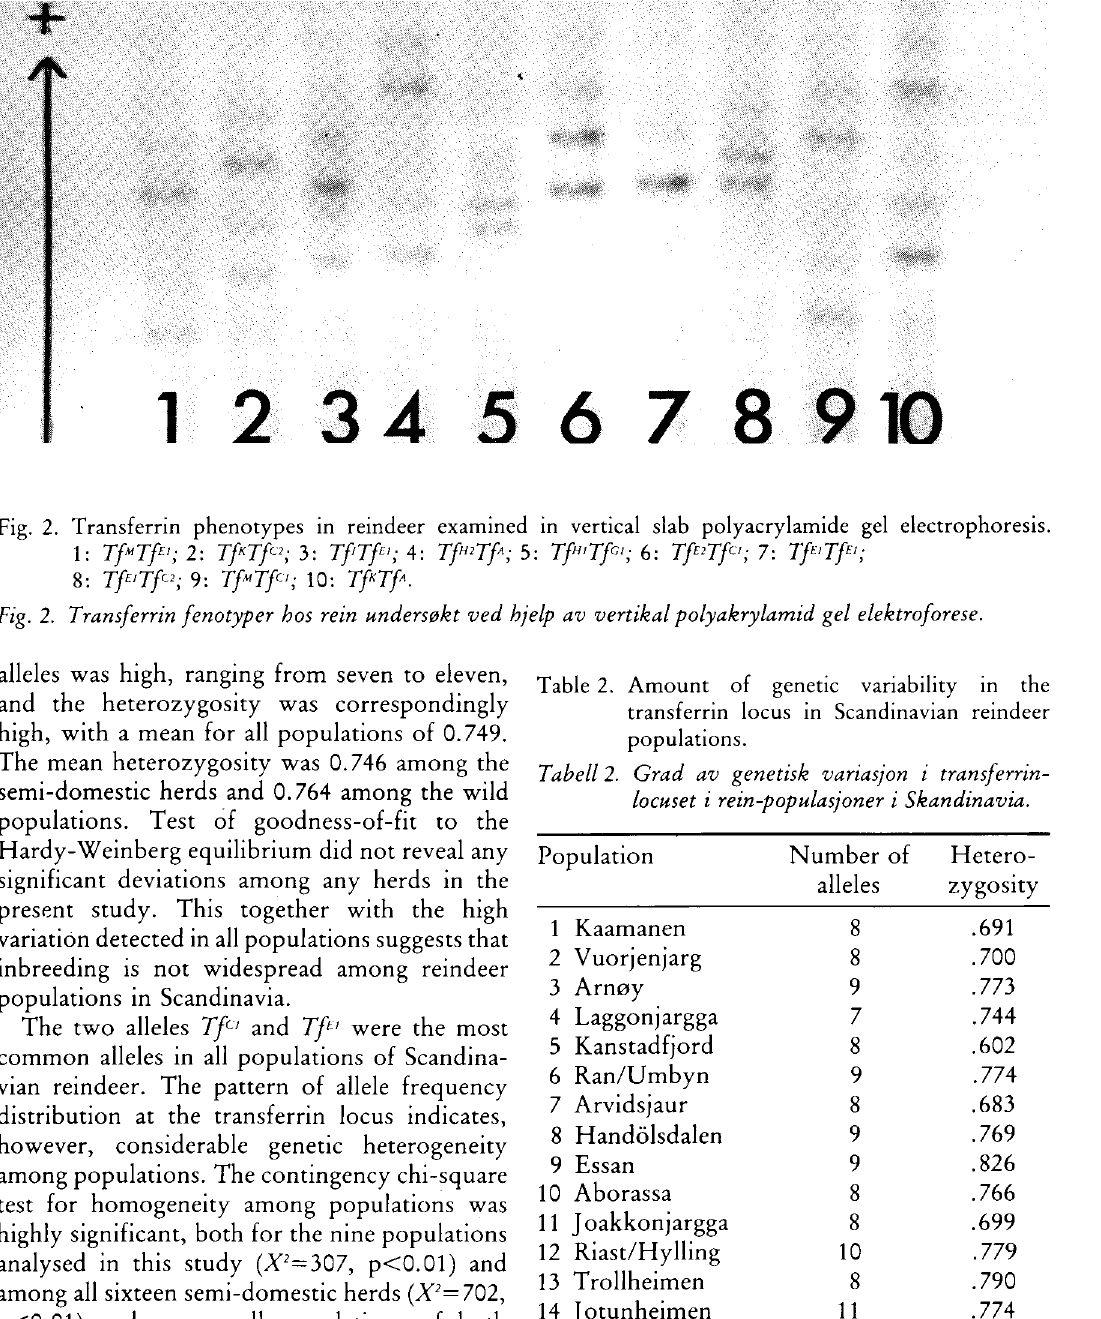
Fig. 2. Transferrin phenotypes in reindeer examined in vertical slab Polyacrylamide gel electrophoresis.